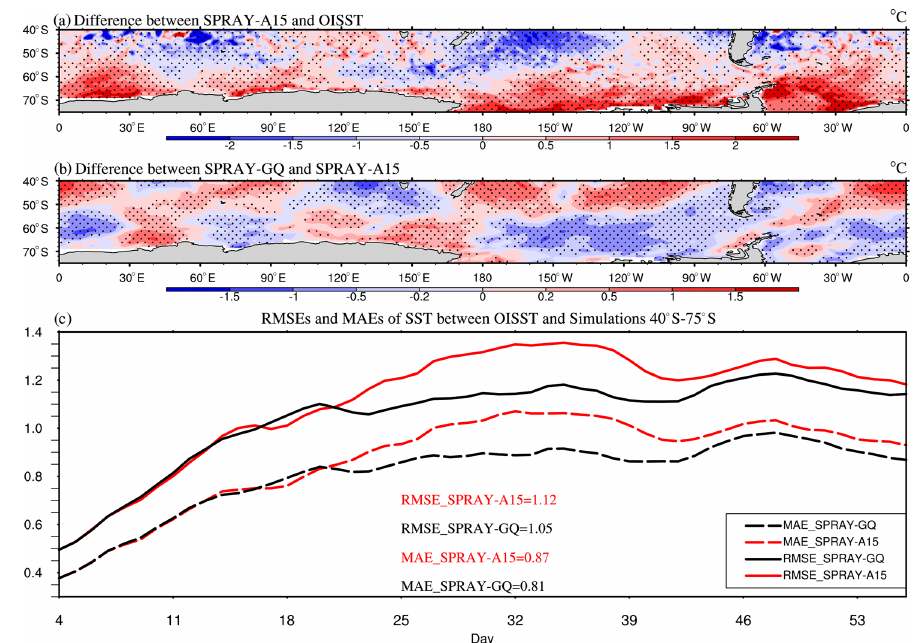
Figure 6. The 53d average SST ( ◦ C) differences between SPRAY-A15 and OISST ( a ; SPRAY-A15 minus OISST), the differences between SPRAY-GQ and SPRAY-A15 ( b ; SPRAY-GQ minus SPRAY-A15), and the time series of domain-averaged RMSE and MAE ( c ; 0–360 ◦ E, 40–75 ◦ S) in January–February 2017. The first 3d simulation is discarded. The dotted areas are statistically significant at 95% confidence level.